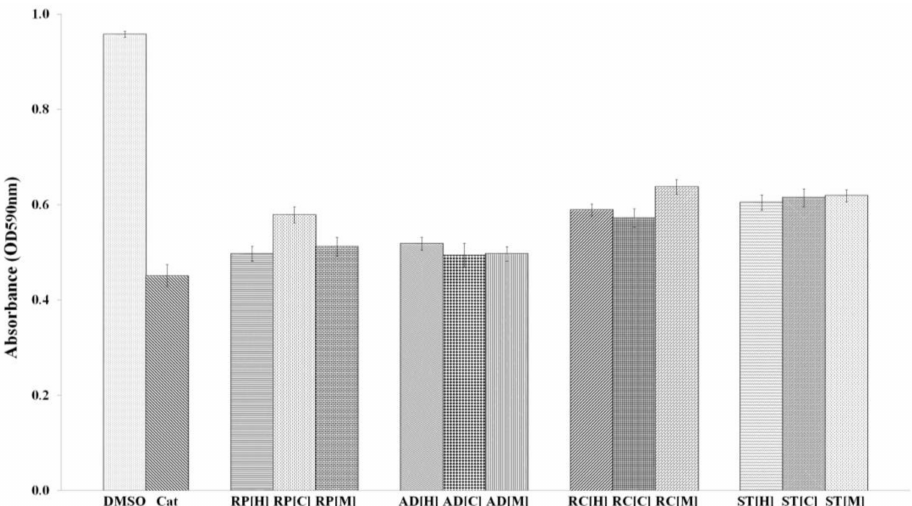
Figure 1. The inhibition of violacein production by the plant extracts, extracted using hexane [H], chloroform [C] and methanol [M]. C. violaceum CV026 incubated with DMSO and catechin (Cat) served as negative and positive controls, respectively. RP, AD, RC and ST correspond to plant extracts from Poria cum Radix pini , Angelica dahurica , Rhizoma cibotii and Schizonepeta tenuifolia at the concentration of 1 mg/mL, respectively. All the compounds with different extraction solvents were found to decrease the production of violacein compared to the negative